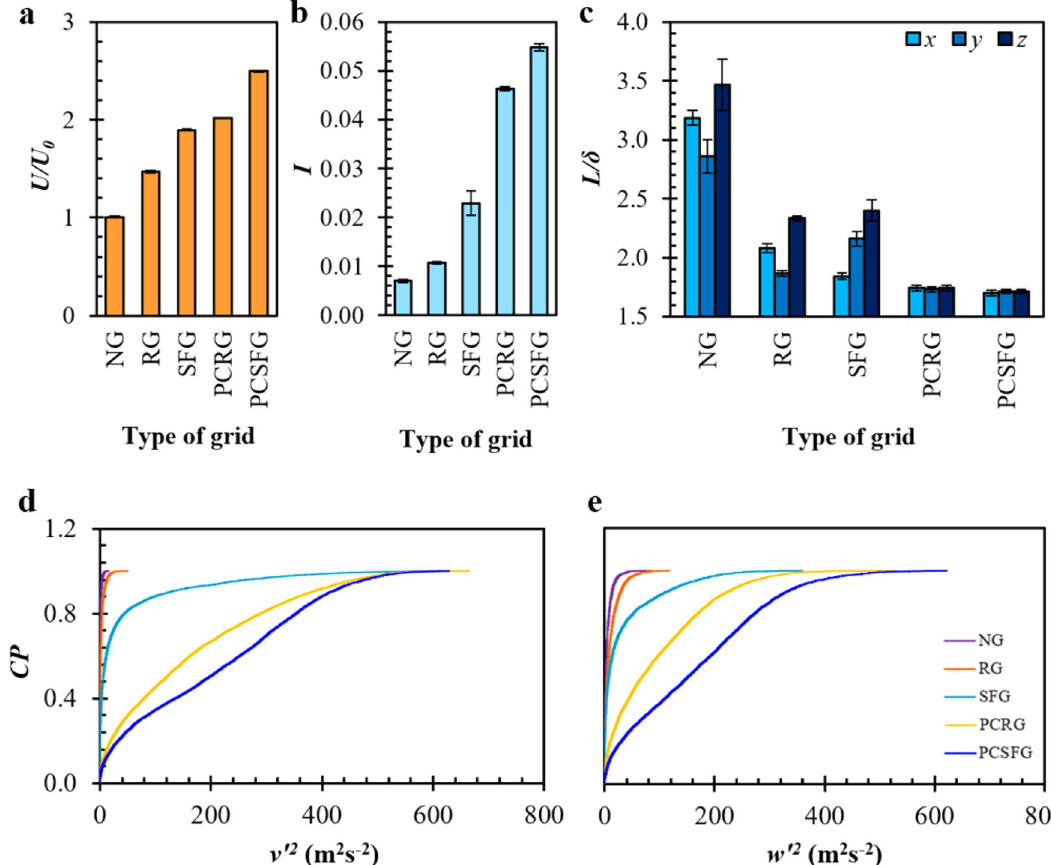
Figure 5. Various grid induced ( a ) U/U 0 , ( b ) I , ( c ) normalized L / δ in ( x , y , z ) directional components at centreline x / D h = 0.125 and cumulative probability distributions of ( d ) v ’2 and ( e ) w ’2